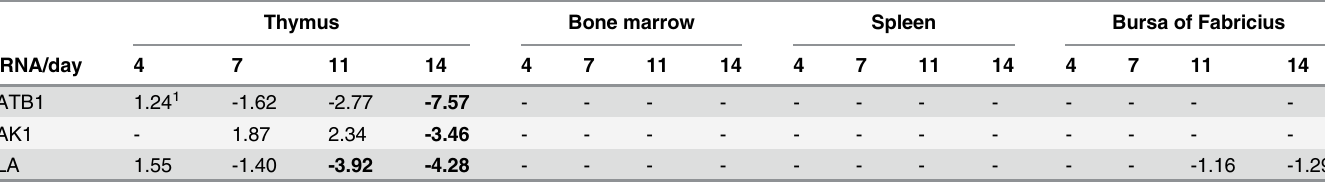
1 Mean fold difference between infected and mock-infected birds at each time-point (n = 5 (6 for d 14)); P < 0.05, positive values are up-regulated in infected birds and negative values are down-regulated in infected birds. — : no signi fi cant difference between groups or mRNA not expressed in one or both groups. Changes greater than three-fold are highlighted in bold.